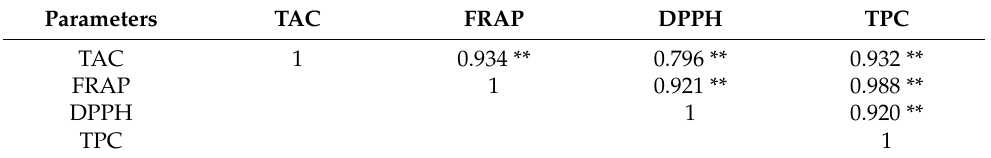
Table 3. Linear correlation coefficients (r) between total anthocyanin content, antioxidant assays (FRAP, DPPH), and total phenolic content in petals of 50 rose varieties obtained by Pearson’s analysis. Parameters TAC FRAP DPPH TPC TAC 1 0.934 ** 0.796 ** 0.932 ** FRAP 1 0.921 ** 0.988 ** DPPH 1 0.920 ** TPC 1 ** Correlation is significant at the 0.01 level